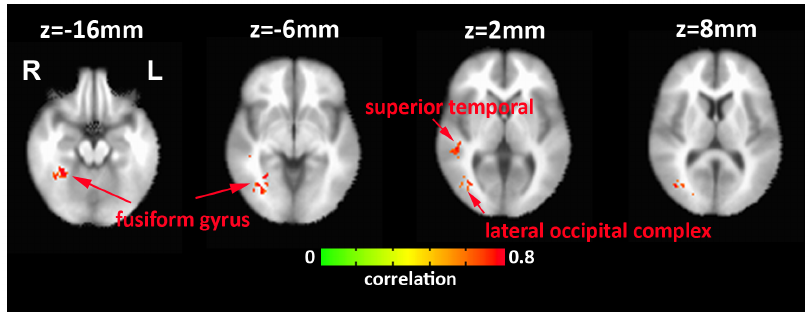
Figure 3. Whole brain correlation map showing regions that exhibit a significant correlation (p , 0.05, corrected for multiple comparisons using AlphaSim in AFNI, minimum cluster size =258 voxels) between performance scores and functional connectivity with the left caudate.